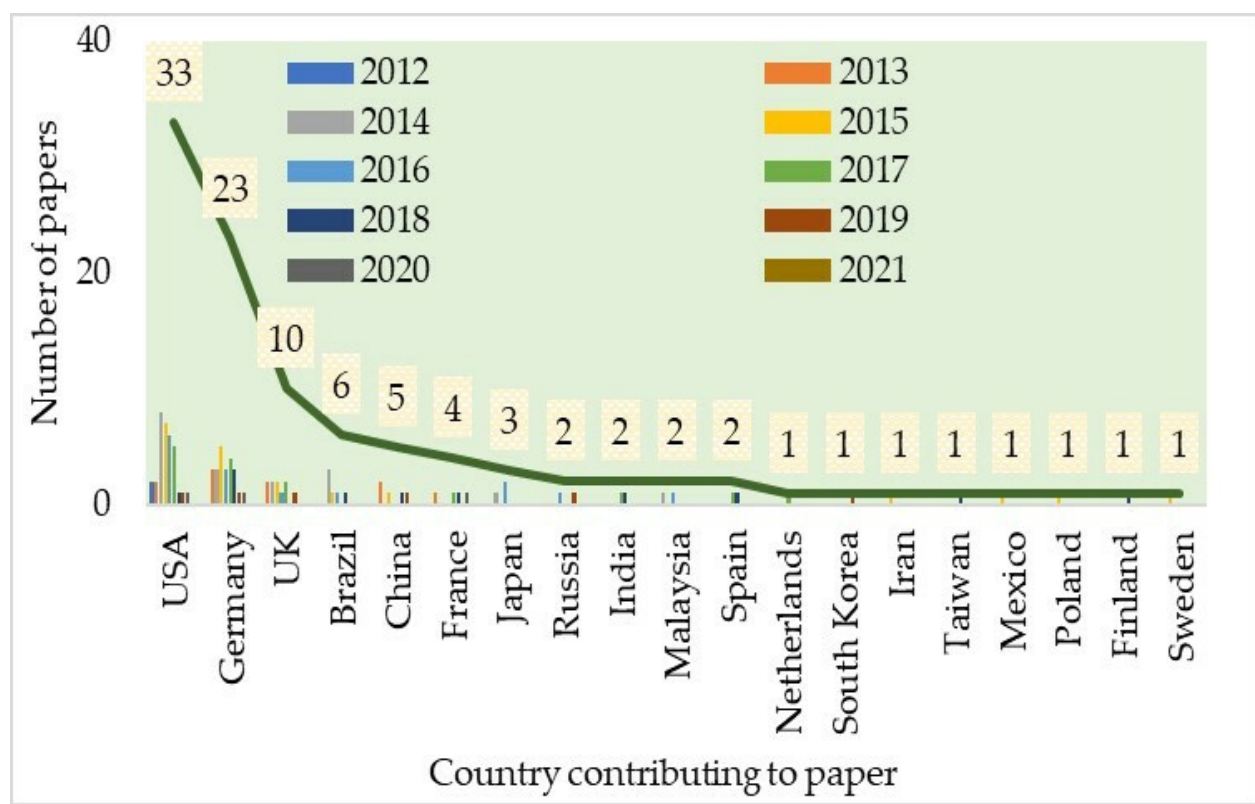
Figure 4. Publishing countries that have contributed to YIG papers during the last ten years.